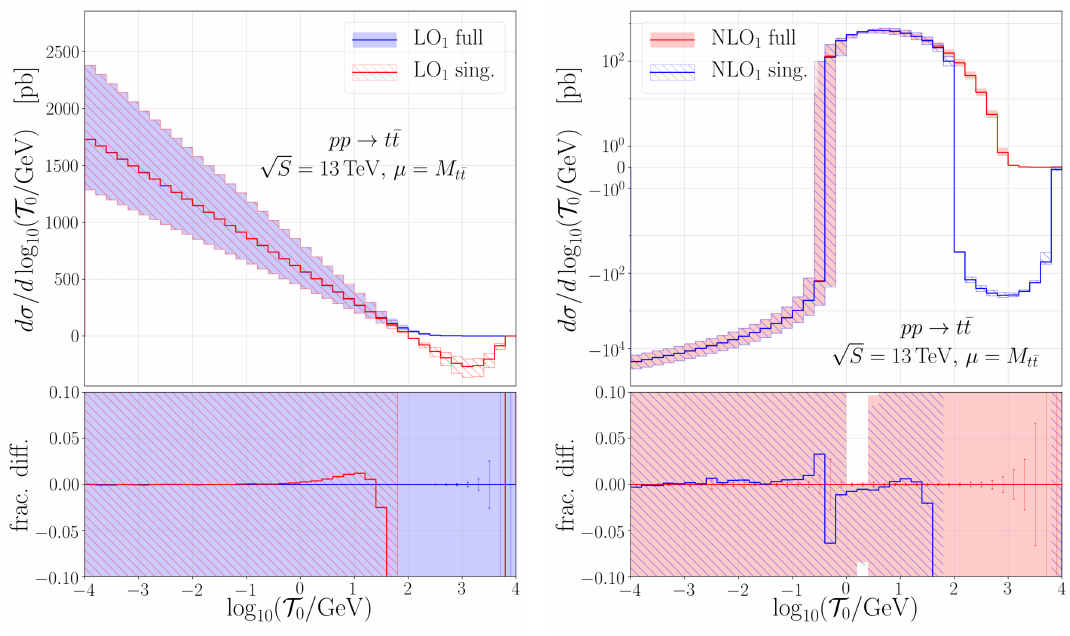
theorem compared with full calculations at LO (left) and NLO (right). The approximate results correctly reproduce the fixed order behaviour in the T 0 → 0